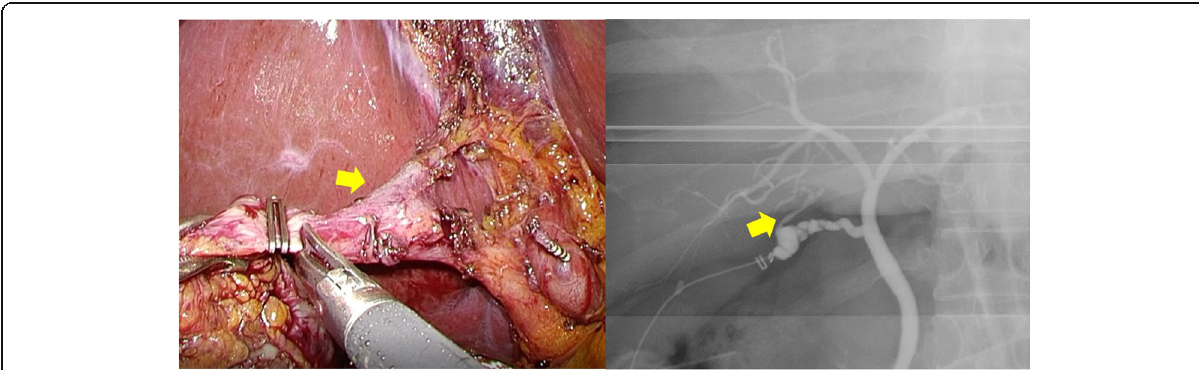
Fig. 3 Laparoscopic exploration showing a connection between the cystic duct and aberrant right hepatic duct (arrow) ending in the liver bed. Intraoperative cholangiography showing that the aberrant right hepatic duct (arrow) was neither confluent to the major hepatic duct nor responsible for draining any liver